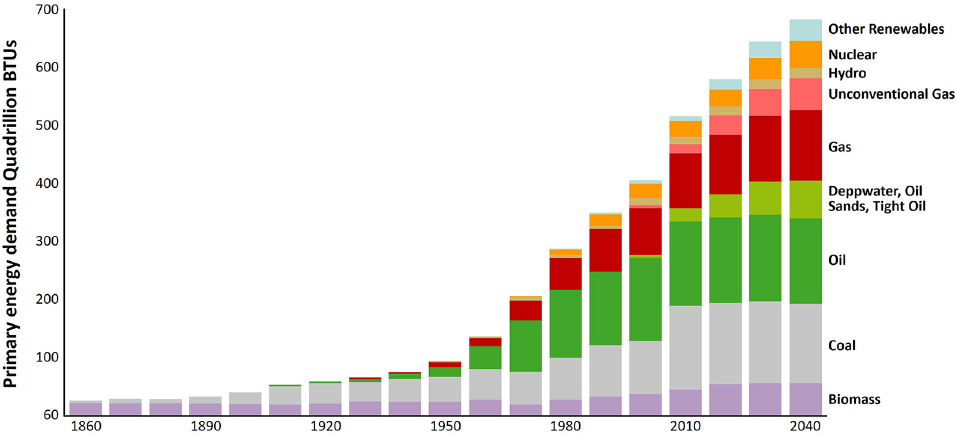
Fig. 9. – Evolution of global energy demand, 1860–2040. Primary energy demand in quadrillion British Thermal Units